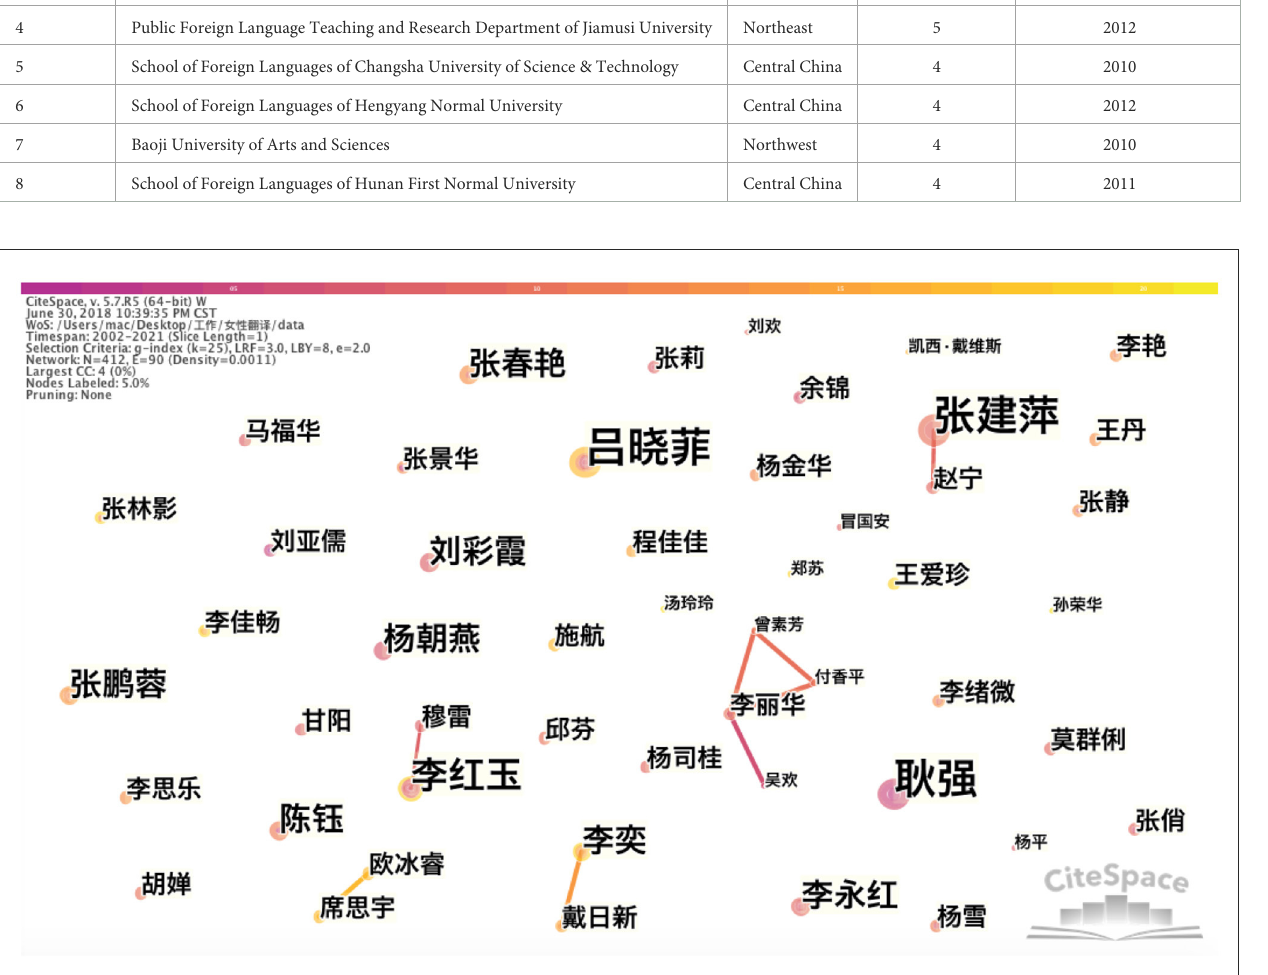
FIGURE3 Bibliometric analysis of researchers of feminist translation research in China from 2002 to